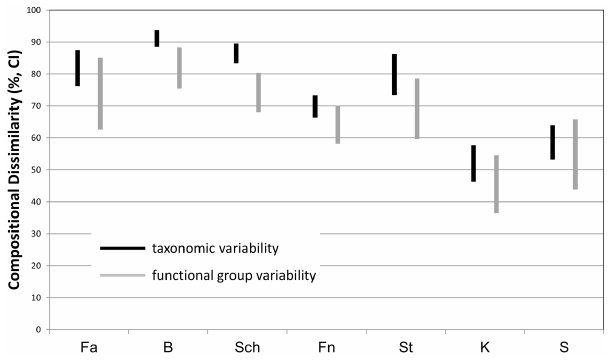
Fig. 10. 95% confidence intervals of interannual variability in taxo- nomic (dark grey bars) and functional composition (light grey bars). The confidence interval defines the zone of interannual variabil- ity considered the natural background “noise” (based on the 6yr surveillance).